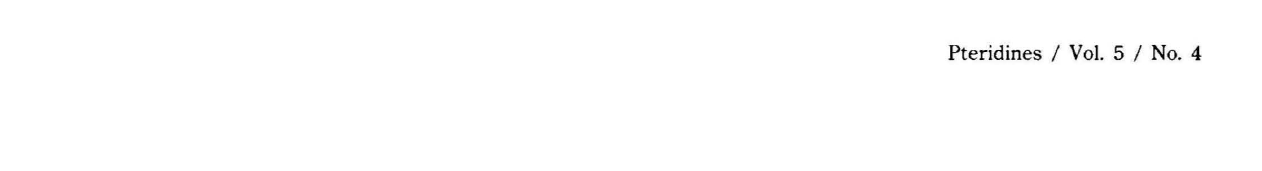
Figure 2. Neopterin vs. ~2·microglobulin correlate well in sALS patients. metric correlations (r5) with two-tailed Ih to avoid incorrect assumption of Gaussian distribution. All correlations were checked by a Runs Test for de viation from linearity; CI = 95% confidence